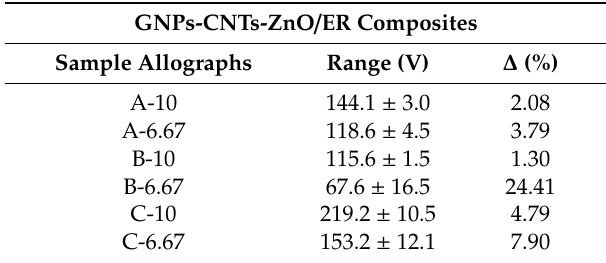
Table 3. Switching threshold voltage of GNPs-CNTs-ZnO / ER samples of six di ff erent